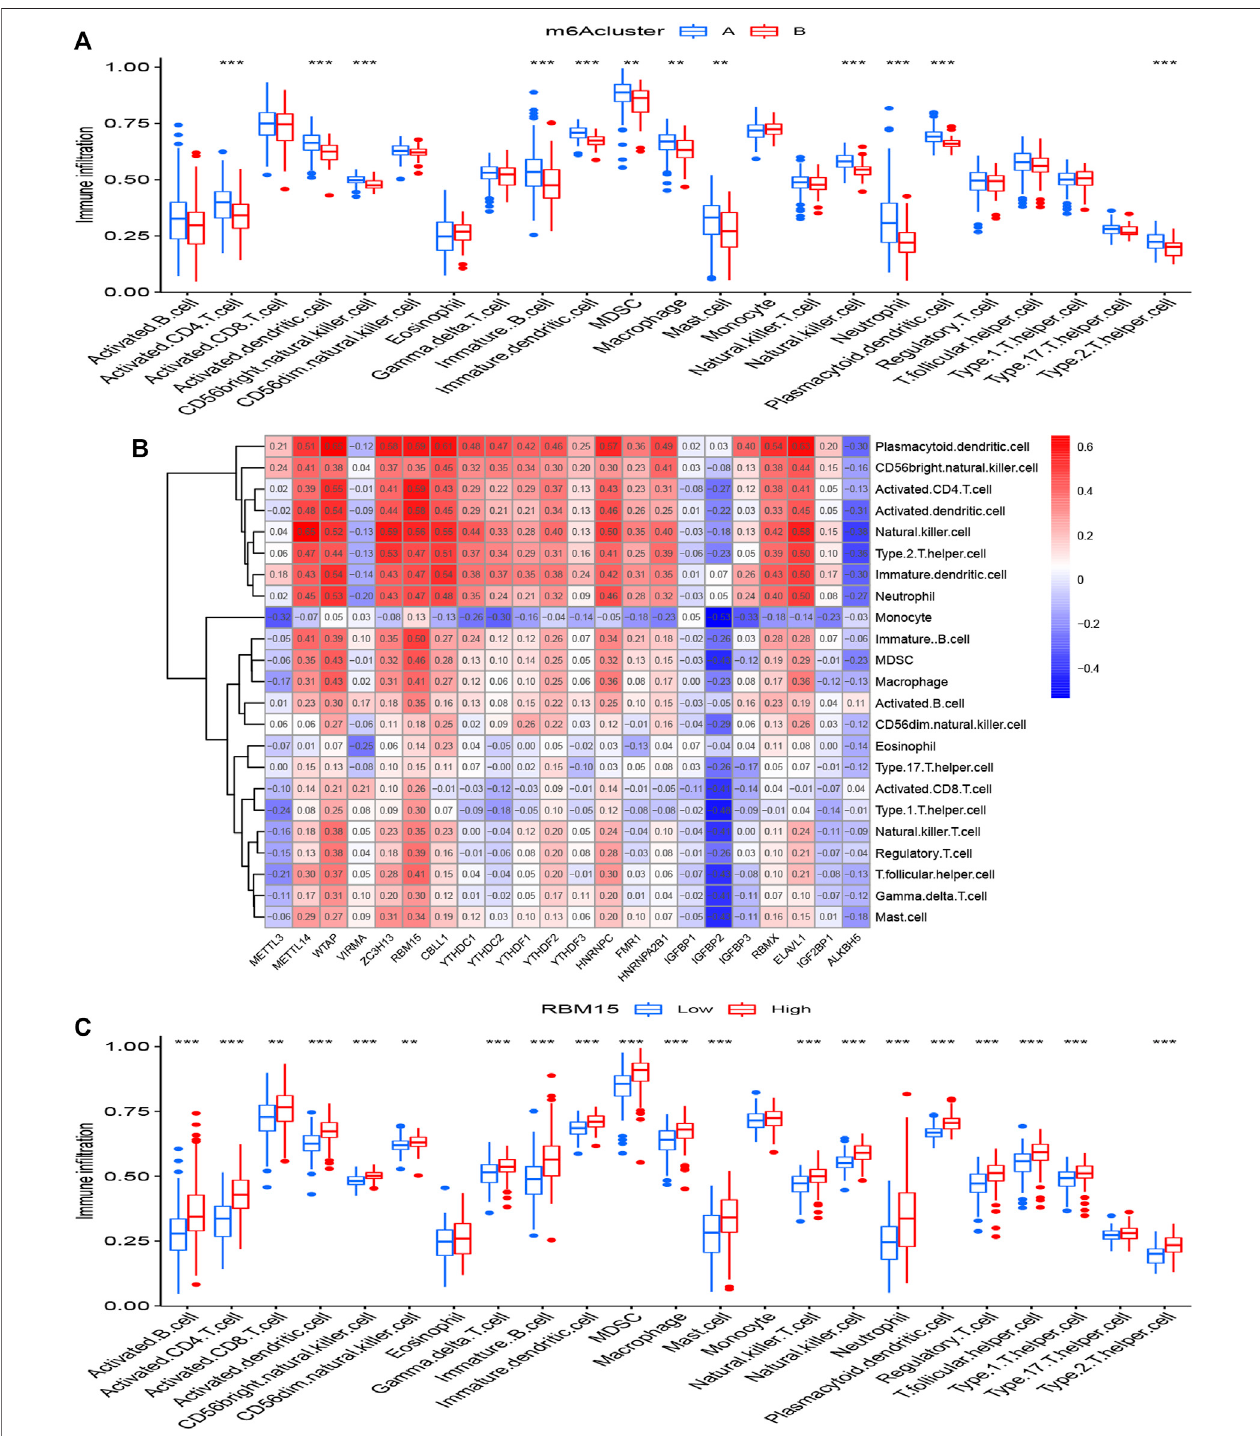
FIGURE 6 | Single sample gene set enrichment analysis (A) The expression status of 22 m6A regulators in the two m6A patterns. (B) Correlation between the 22 signi fi cant RNA N6-methyladenosine regulators and in fi ltrating immune cells. (C) Differential immune cell in fi ltration between low RBM15 expression group and high RBM15 expression group. * p < 0.05, ** p < 0.01, and *** p < 0.001.